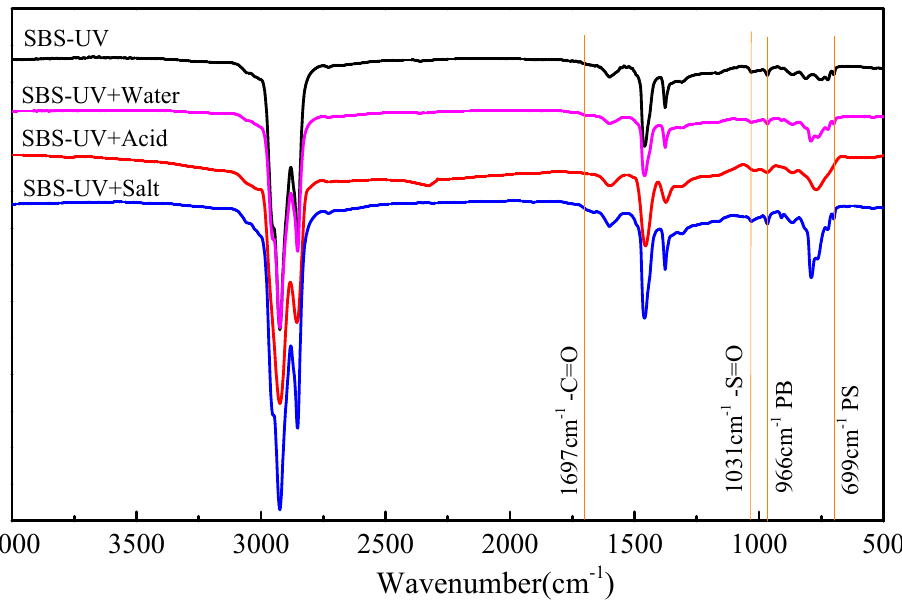
Figure 7. FTIR spectra of SBS modified bitumen before and after UV aging in different environments.